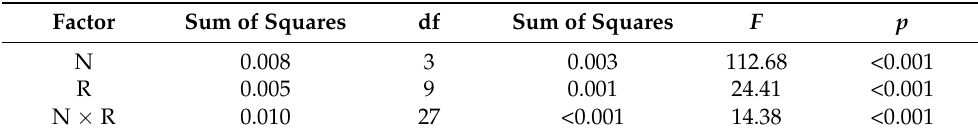
Figure 4. Mean N 2 O emission from four nitrogen addition treatments during the experiment period. Bars represent the LSD (p = 0.05) values between four nitrogen levels on each day, n = 3. N 2 O emissions were significantly affected by the nitrogen addition amount ( p < 0.001) and rainfall ( p < 0.001, Table 3). Furthermore, there was an interaction effect between nitrogen addition and rainfall on the N 2 O emissions ( p < 0.001). Table 3. Two-way ANOVA for the effects of nitrogen addition amount (N) and rainfall (R) on N 2 O emission, n = 30.